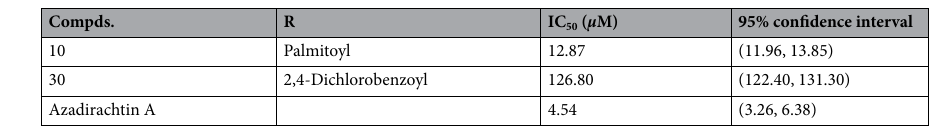
Table 4. The half maximal inhibitory concentration (IC 50 ) of target compounds against Sf9 cells. The experiments were repeated six times.